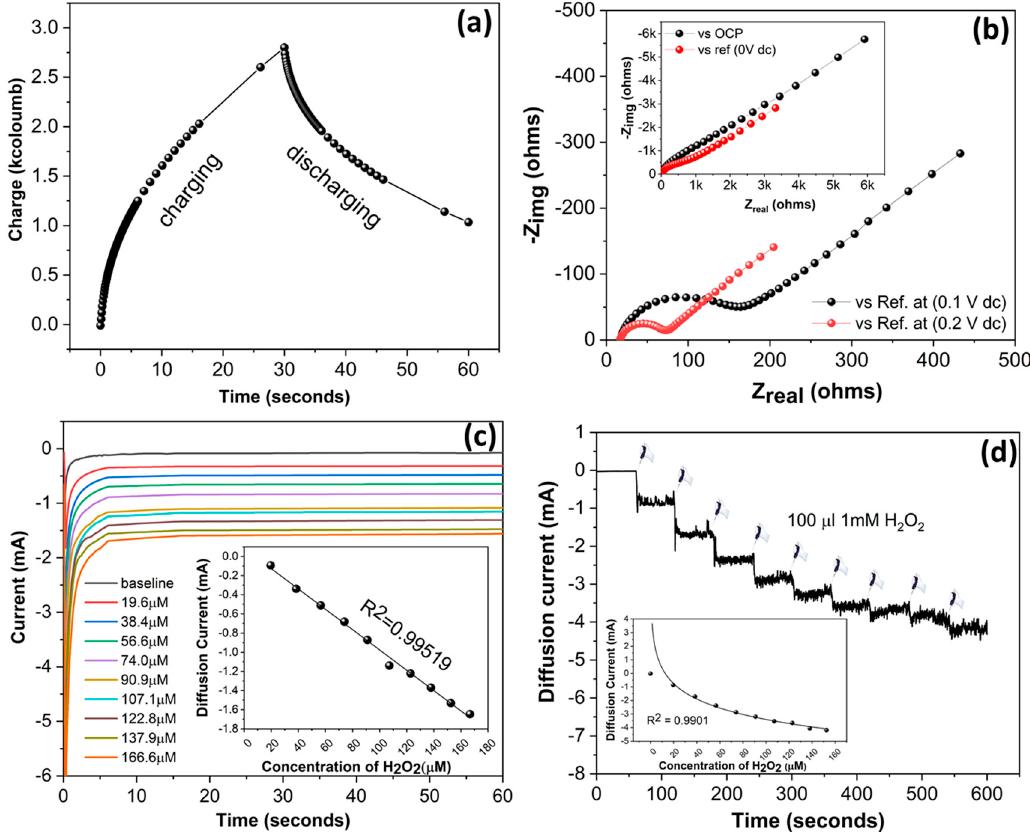
Figure 3. ( a ) Chrono-coulometric single-cycle characterization of SENCE showing proper charging and discharging behavior in a redox environment. ( b ) Electrochemical impedance spectroscopy (EIS) Nyquist behavior of SENCE with a direct current (DC) bias of 0.1 V and 0.2 V showing proper charge transfer. The same experiment in an open circuit and without bias is depicted in the inset. ( c ) Chrono-amperometric sensing of H 2 O 2 along with calibrated dose response (inset). ( d ) Continuous sensing of H 2 O 2 along with calibrated dose response (inset).